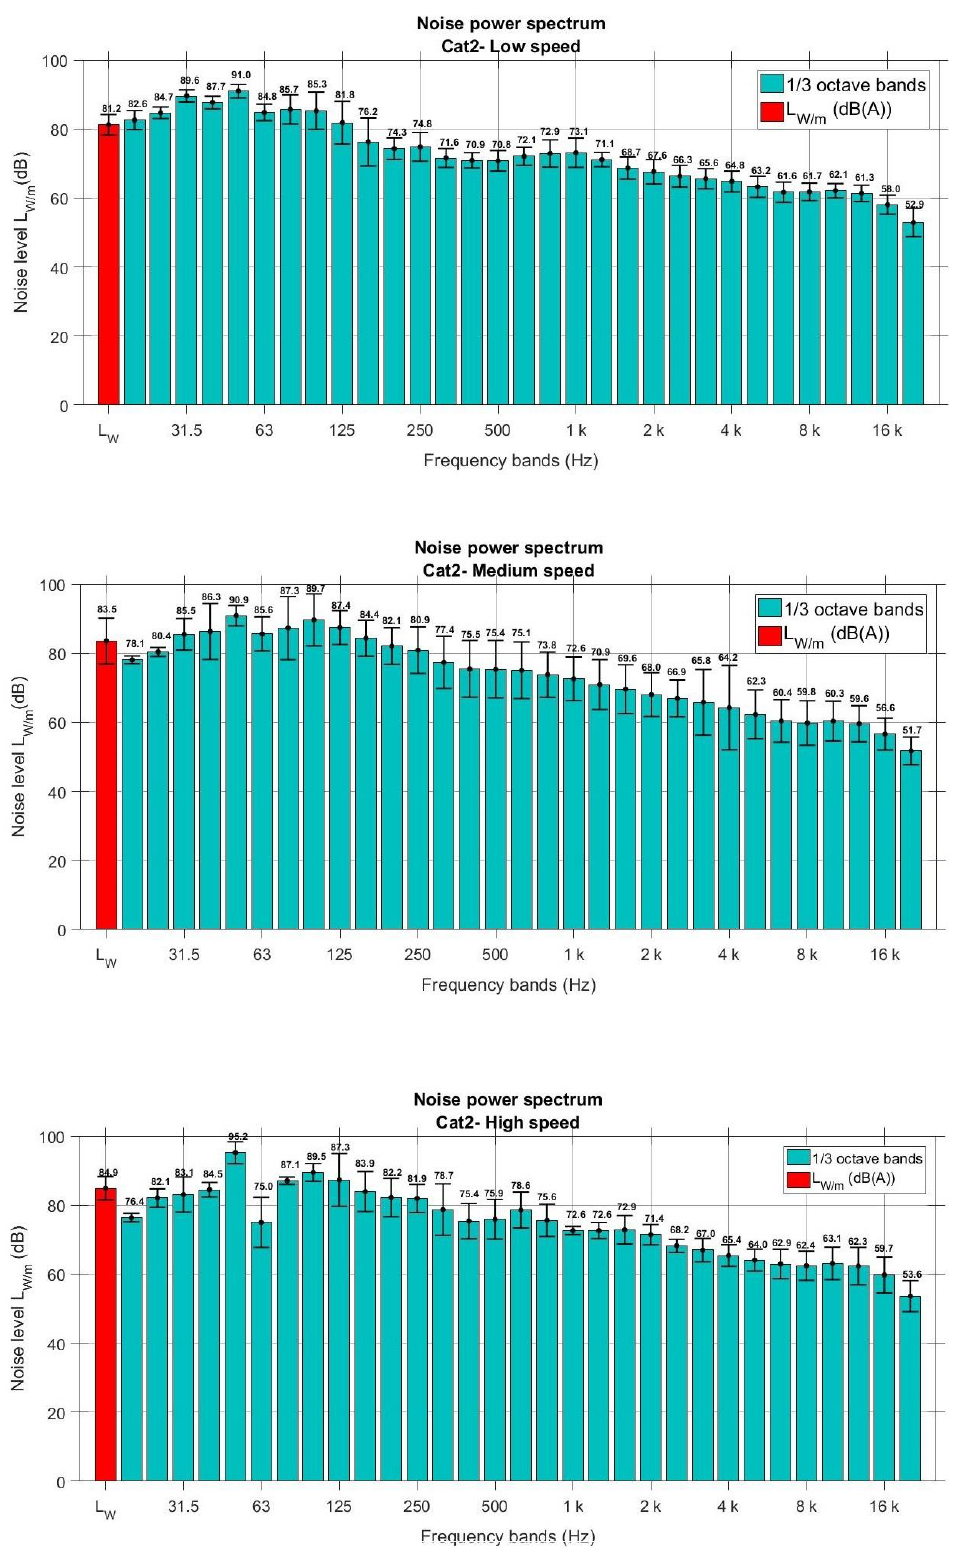
Figure 4. L W/m and 1/3 octave band sound power spectra of Cat2 vessels for low-, medium-, and high-speed classes together with uncertainties.